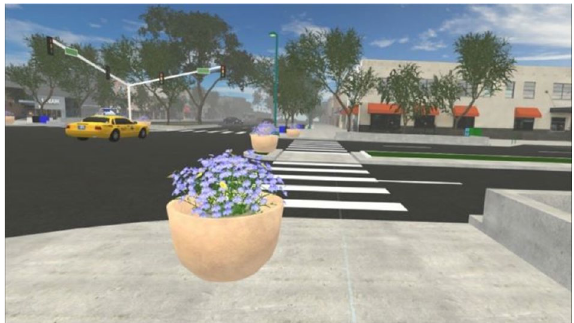
Figure 3. Example scene from modifiable VR environment used in pilot research.